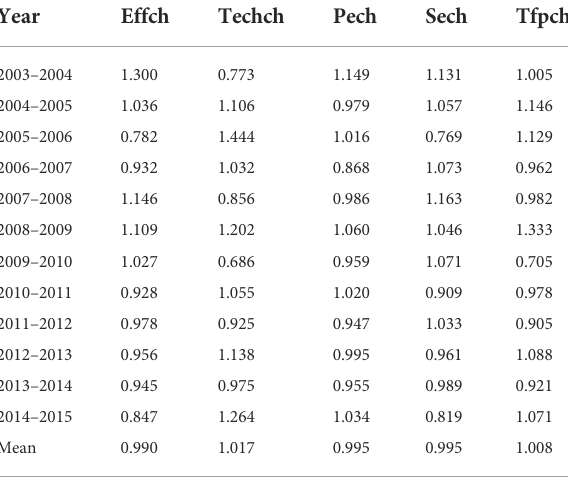
TABLE4 Malmquistindex ofrurallandoutsourcingef fi ciency inChina from 2003 to 2015.